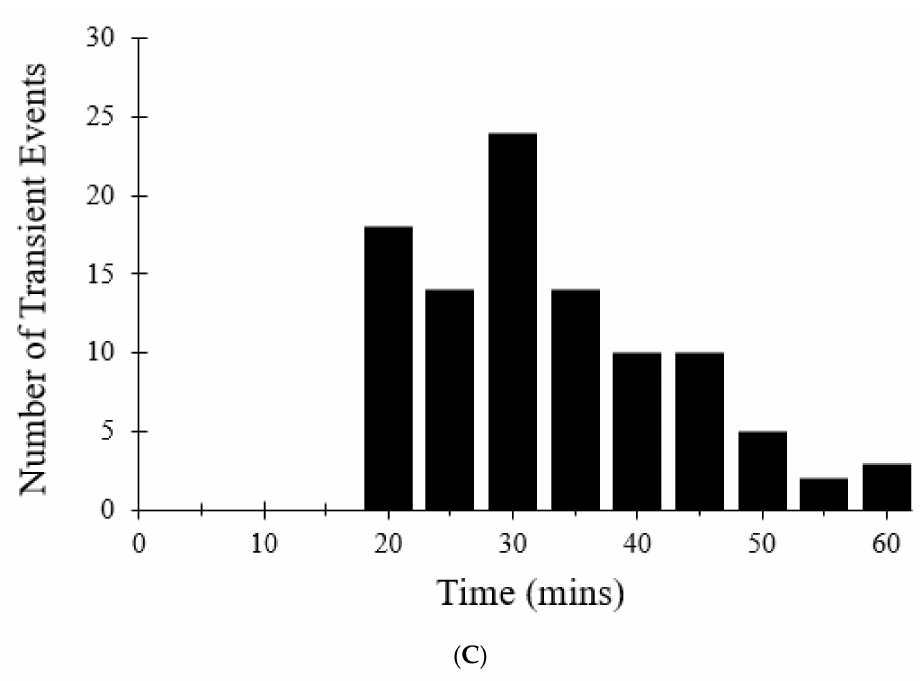
Figure 9. Transition from transient to permanent opening events under increased intensity of laser irradiation (photon stress). ( A ) Simulated regional TMRM fluorescence over time during transition from transient to permanent opening events. ROS levels were increased to replicate the effects of increased photooxidation on ROS production. Data was collected from 6 regions of interest inside the cell. Mitochondrial membrane potential during the transition from transient to permanent opening events with increased photon stress. ( B ) Regional experimental TMRM fluorescence over time during transition from transient to permanent opening events [7]. ( C ) Number of transient opening events per cell per minute with increased photon stress. A simulation of 100 pores was used to collect